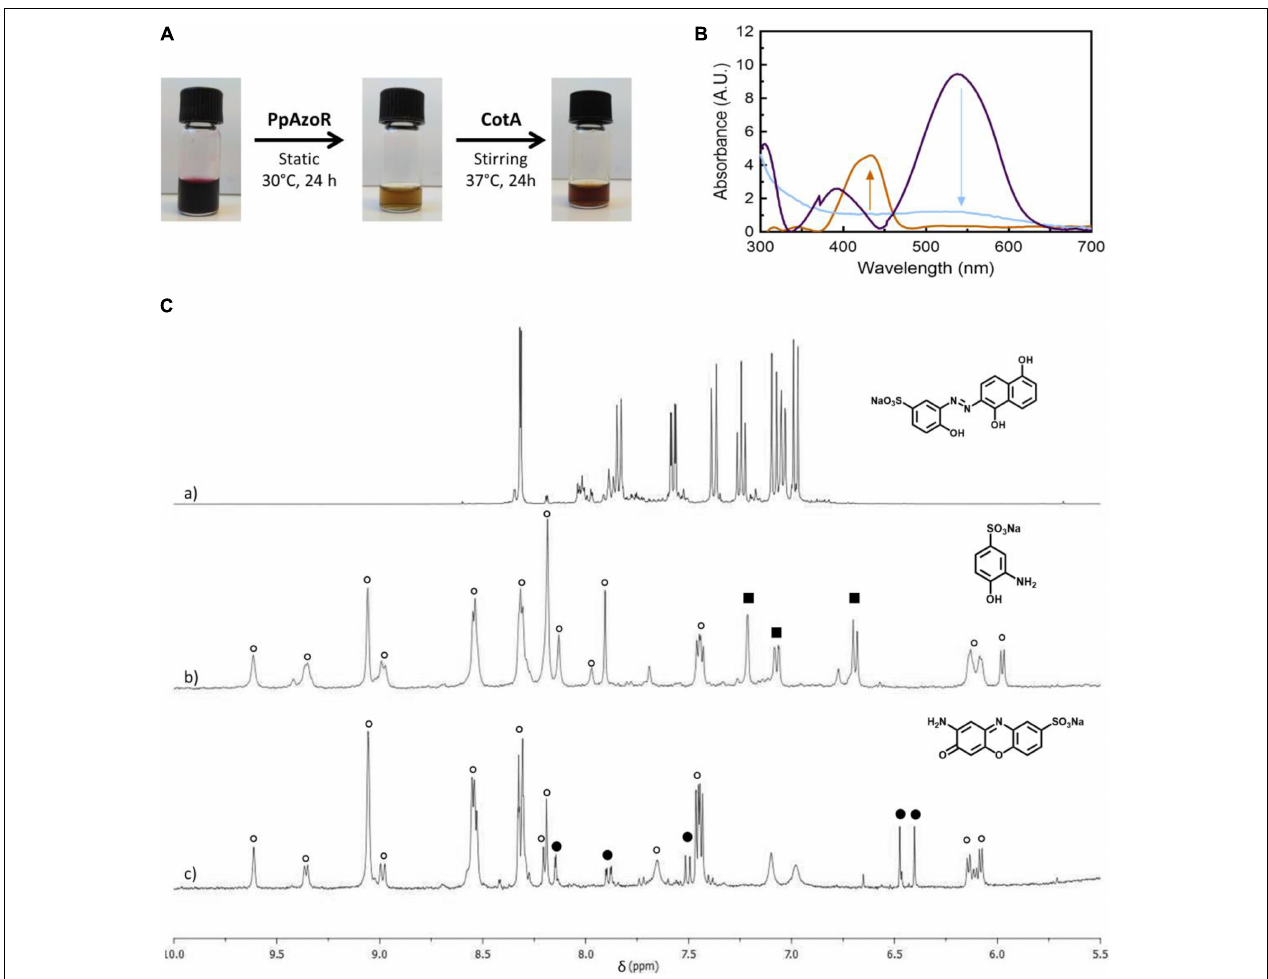
FIGURE 1 | (A) Products of the MB9 bioconversion upon the sequential reaction with purified PpAzoR azoreductase and CotA-laccase, under anaerobic and aerobic conditions, respectively. (B) UV–Vis spectra of the initial reaction mixture (purple) and after reaction with PpAzoR azoreductase (light blue) and CotA-laccase (light brown). (C) 1 H-NMR spectra (aromatic region) of MB9 (a) and of the products of reaction after addition of PpAzoR azoreductase (b) and CotA-laccase (c) . Resonances due to NAD + and other intermediates resulting from NADH/NAD + degradation (open circles), SAHBS (filled squares), and compound 7 (filled circles) are